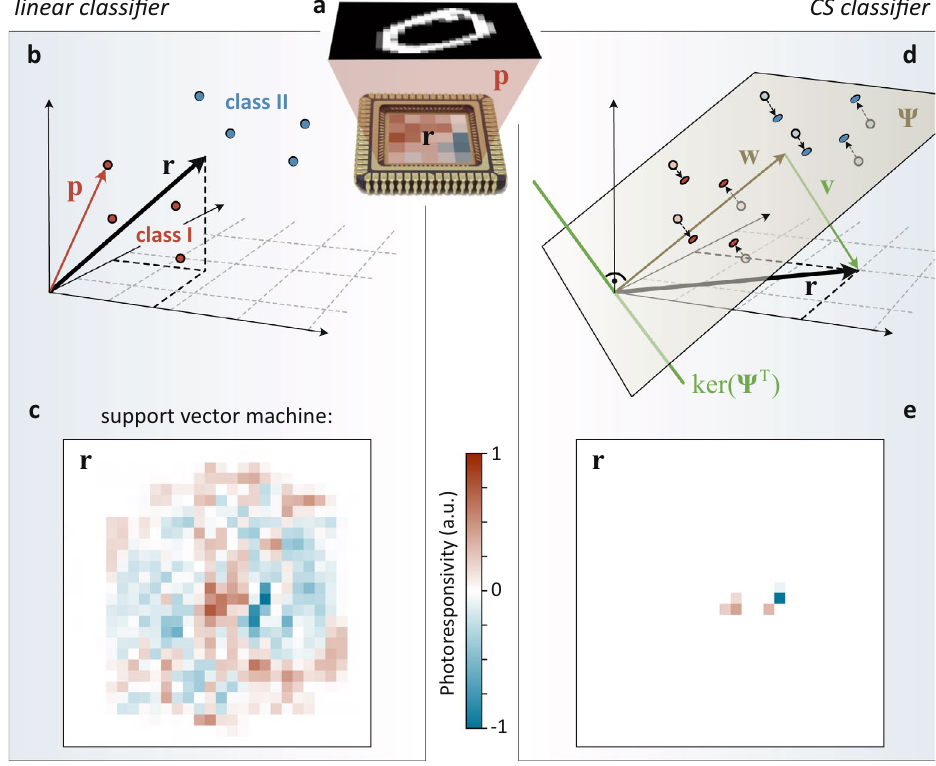
Figure 1. Theoretical background and operation principle. ( a ) Schematic illustration of the setup. An optical image p is projected onto the face of the image sensor with photoresponsivity values r that vary from pixel to pixel. ( b ) A binary linear classifier assigns an image to one of two possible classes I or II, depending whether or not the inner product r T p is larger than some threshold. In our implementation, the inner product is realized by summing up the photocurrents produced by all detector elements. ( c ) Photoresponsivities for a sensor that has been trained as a linear SVM for the classification of zeros and ones from the MNIST dataset. Almost all pixels exhibit non-zero photoresponsivity values. ( d ) Natural images have low-dimensional structure. This allows to construct a sparse photoresponsivity vector r for classification. ( e ) Results for the same binary classification task as in c. Comparable performance is achieved with 99.2% of the detector elements having zero